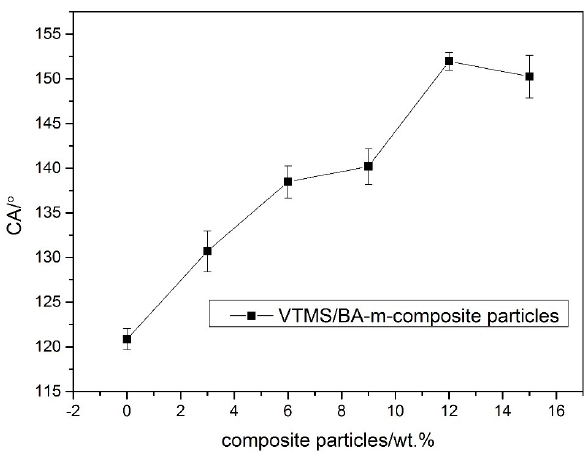
Figure 16: The influence of composite particles with different mass fractions on the contact angle of UV curable hybrid